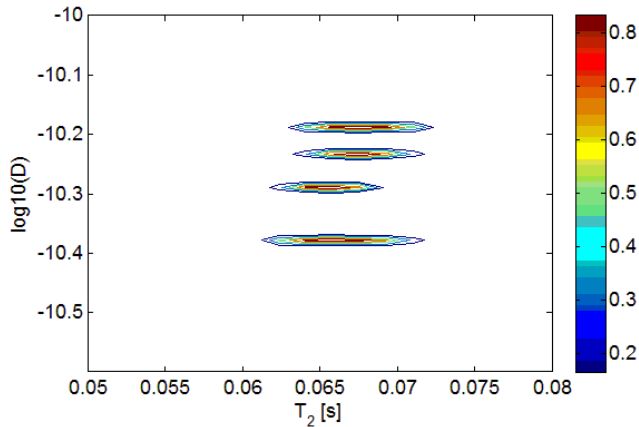
Figure 3. Superimposition of D-T distributions of sunflower and extra virgin olive mixed 2 oils. From top to bottom, the peaks correspond to pure extra virgin olive oil, 10% sunflower oil, 20% sunflower oil and pure sunflower oil,